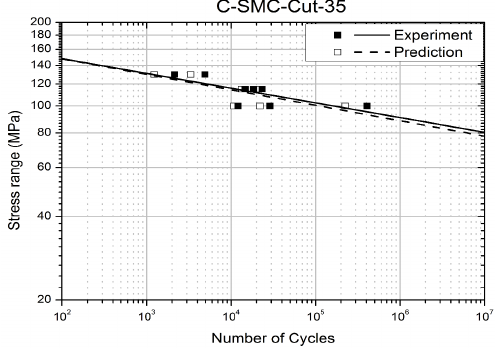
Figure 25. Prediction of the fatigue life for C-SMC-Cut-35 compared with the